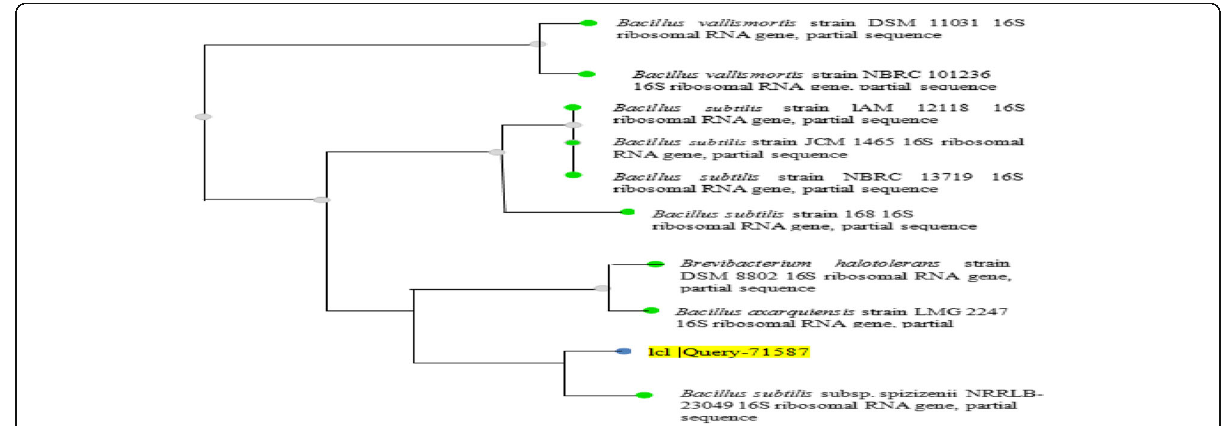
Fig. 2 Phylogenetic tree based on the 16S rRNA sequences of isolate and its closest Bacillus sp.